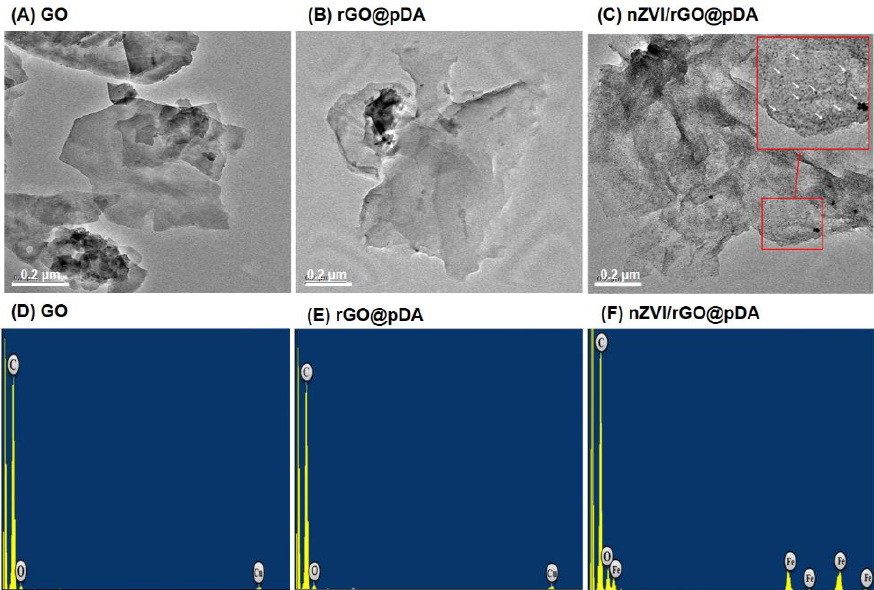
Figure 1. Transmission electron microscopy images of preparations. Images show representative micrographs of ( A ) GO, ( B ) rGO@pDA, and ( C ) nZVI/rGO@pDA. White arrows denote nZVI and the red boxes indicate higher magnification of the indicated area. The bottom panels show energy-dispersive X-ray spectra of ( D ) GO, ( E ) rGO@pDA, and ( F ) nZVI/rGO@pDA. Abbreviations: GO, graphene oxide; nZVI/GO, reduced graphene oxide modified with dopamine; nZVI/rGO@pDA, nano zero-valent iron immobilized on the surface of reduced graphene oxide then modified with dopamine.